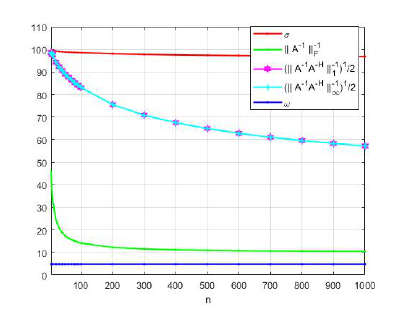
Figure 7: a 1 , a 2 , a 3 , a 4 , a 5 , a 6 , a 7 , a 8 = 20/7, 2/7, 4/7, 6/7, 1/7, 5/7, 3/7, 1 [i=8] .